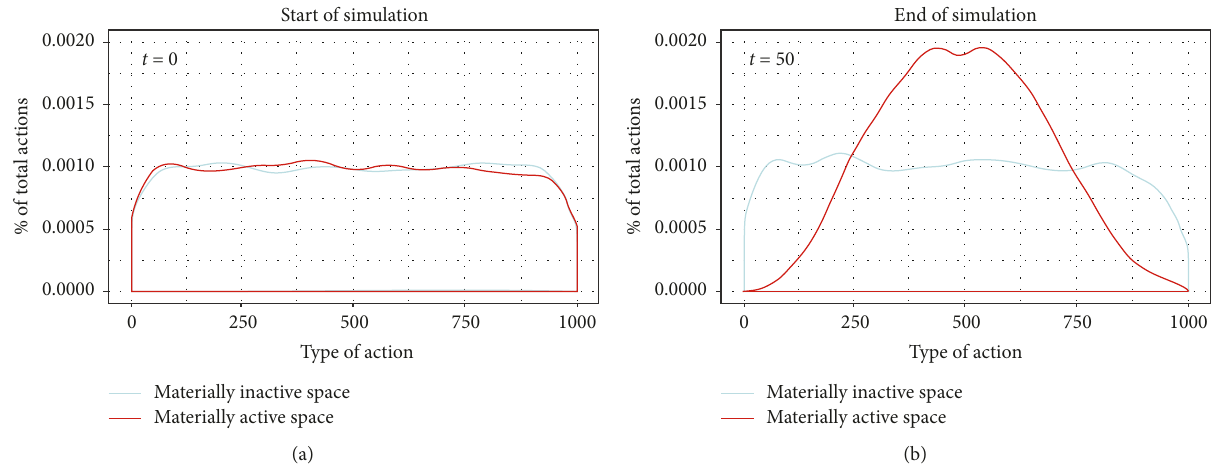
Figure 7: Histogram of probability distribution of actors performing different types of action at the start (a) and at the end (b) of simulations in scenarios where distance is not considered (blue) and distance is considered, aligning orientations in action coordination (red). Results are averaged for 30 runs for 125 parameter combinations.